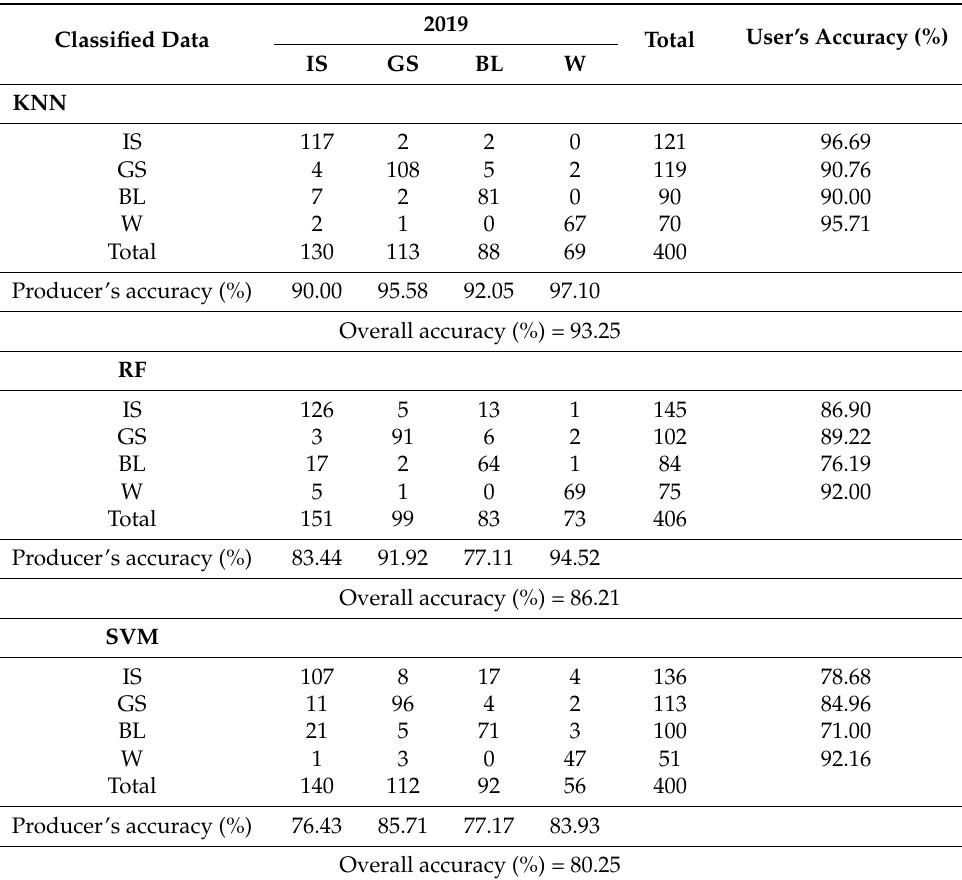
Table A4. Accuracy instructions of the classified LUC maps of